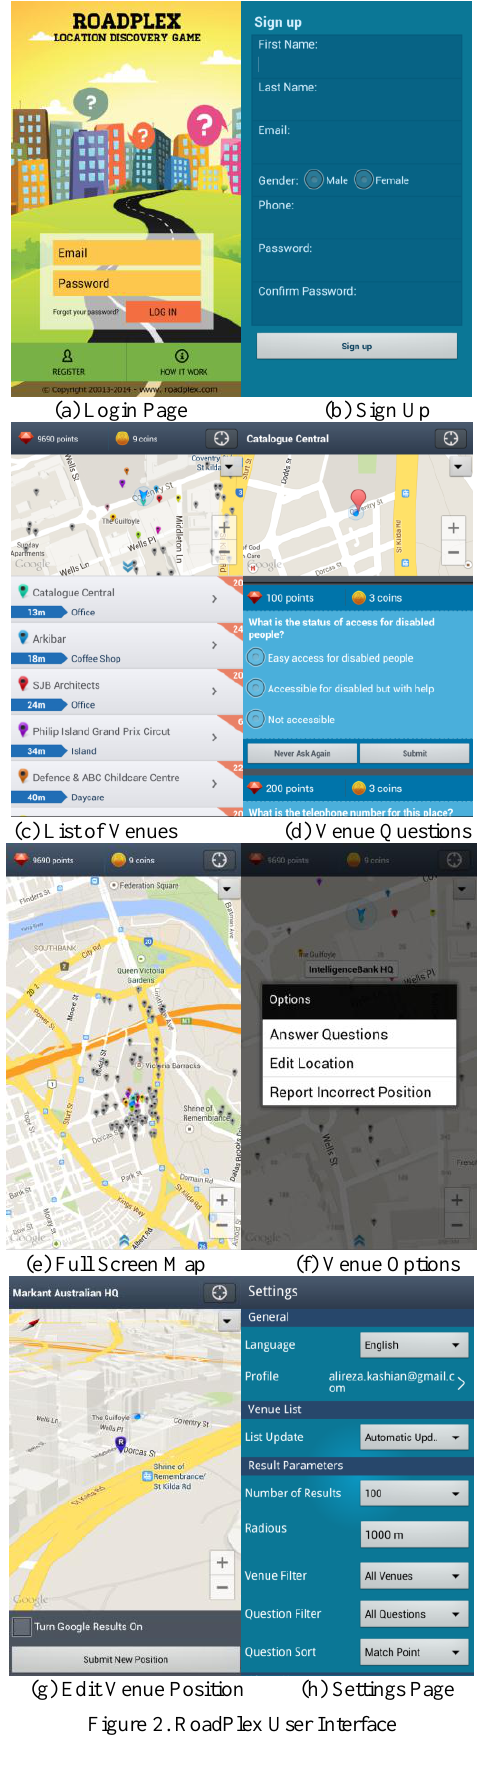
Figure 2. RoadPlex User